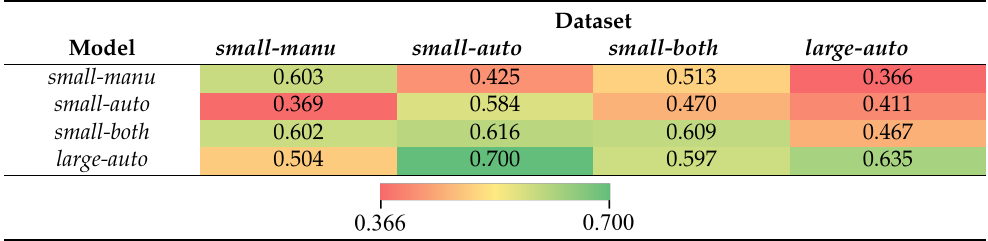
Table 5. Intersection over union of all four models evaluated on each of the four test datasets (names in italics), computed as described in Section 2.2.3.